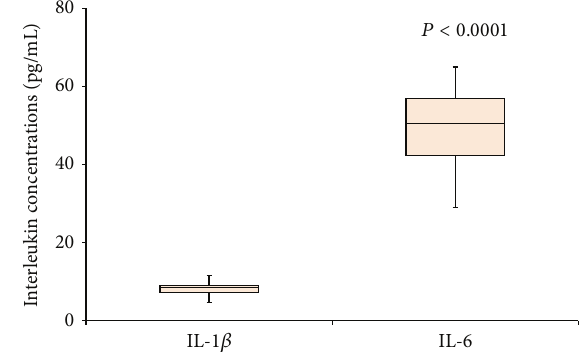
Figure 2: Levels of IL-1 𝛽 and IL-6 in LRTI patients are shown in the figure. Box plot representation was used. IL-6 level was significantly higher compared to IL-1 𝛽 ( 𝑃 < 0.0001